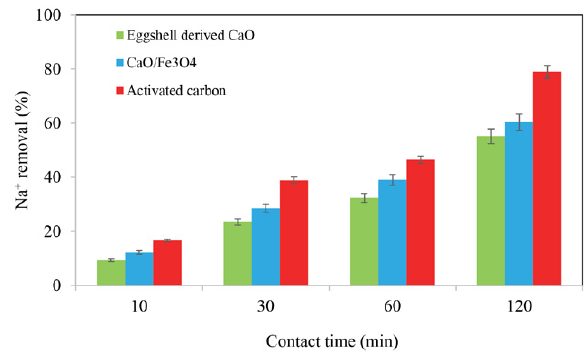
Figure 1. Primary investigations about three studied adsorbents in 10, 30, 60, and 120 min and neutral